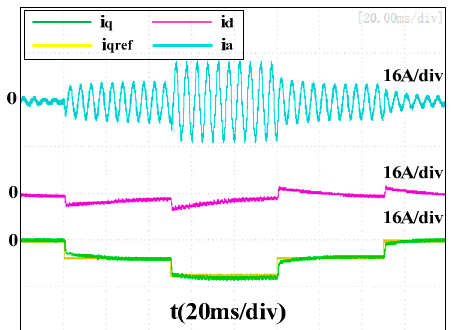
14 of 18 Figure 18. d-q axis current waveform of the current controller with feedback decoupling at 12,000 rpm with Kp = 500 π Ls. Figure 19. d-q axis current waveform of the proposed accurate discrete current controller at 12,000 rpm with Kdq = 500 π Ls. Figures 20–22 present the experimental results of the three current controllers at 12,000 rpm with a proportional gain of 1000 π Ls . The performances of the two conventional controllers were improved compared to Figures 17 and 18. The transient errors and recovery time were reduced. The q-axis current seen in Figure 22 was faced with a small overshoot when its reference changed, but the performance of the proposed accurate discrete current controller with a lower proportional gain of